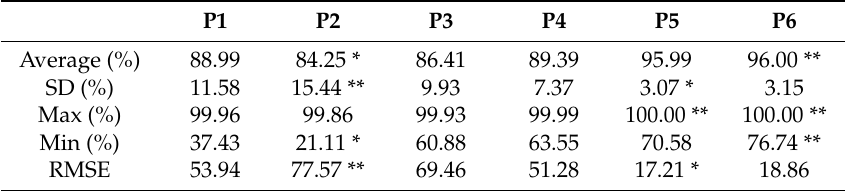
Figure 17. Prediction accuracy of the daylight illuminance on the workplane at points ( a ) P1, ( b ) P2, ( c ) P3, ( d ) P4, ( e ) P5, and ( f ) P6. Table 5. Accuracy analysis for the prediction of the daylight illuminance on the workplane at points P1–P6.